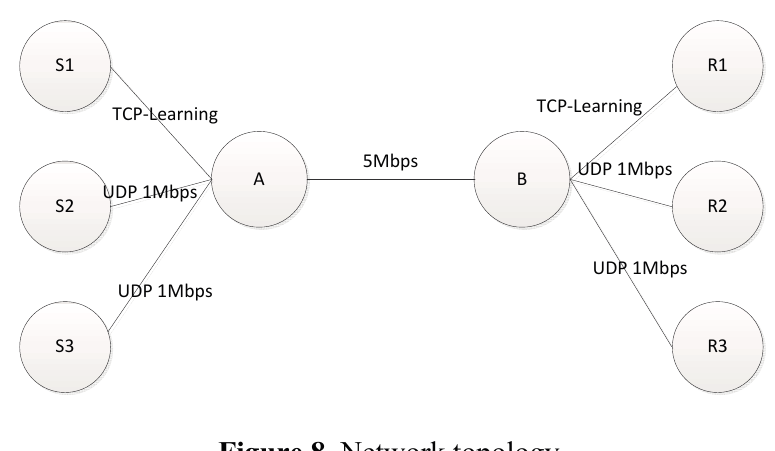
Figure 8. Network topology.